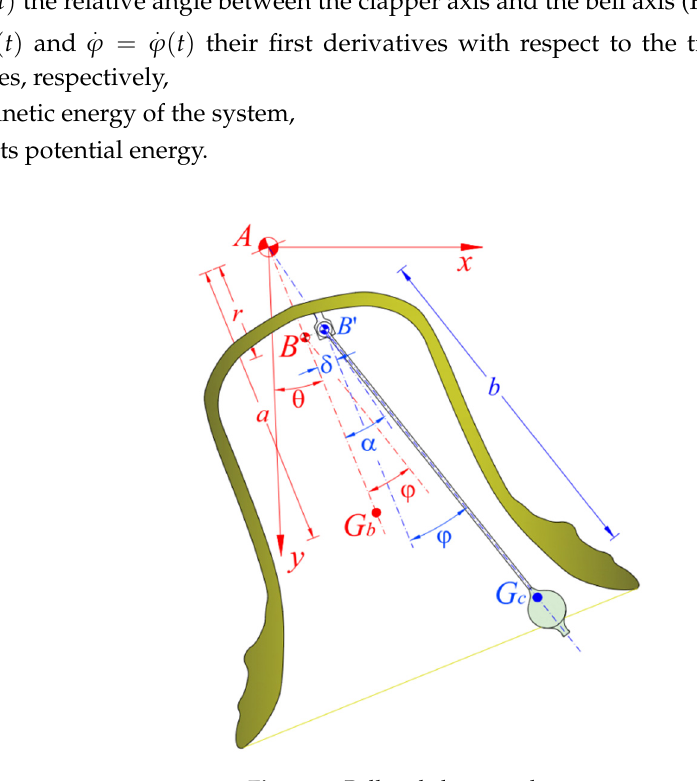
Figure 1. Bell and clapper scheme.